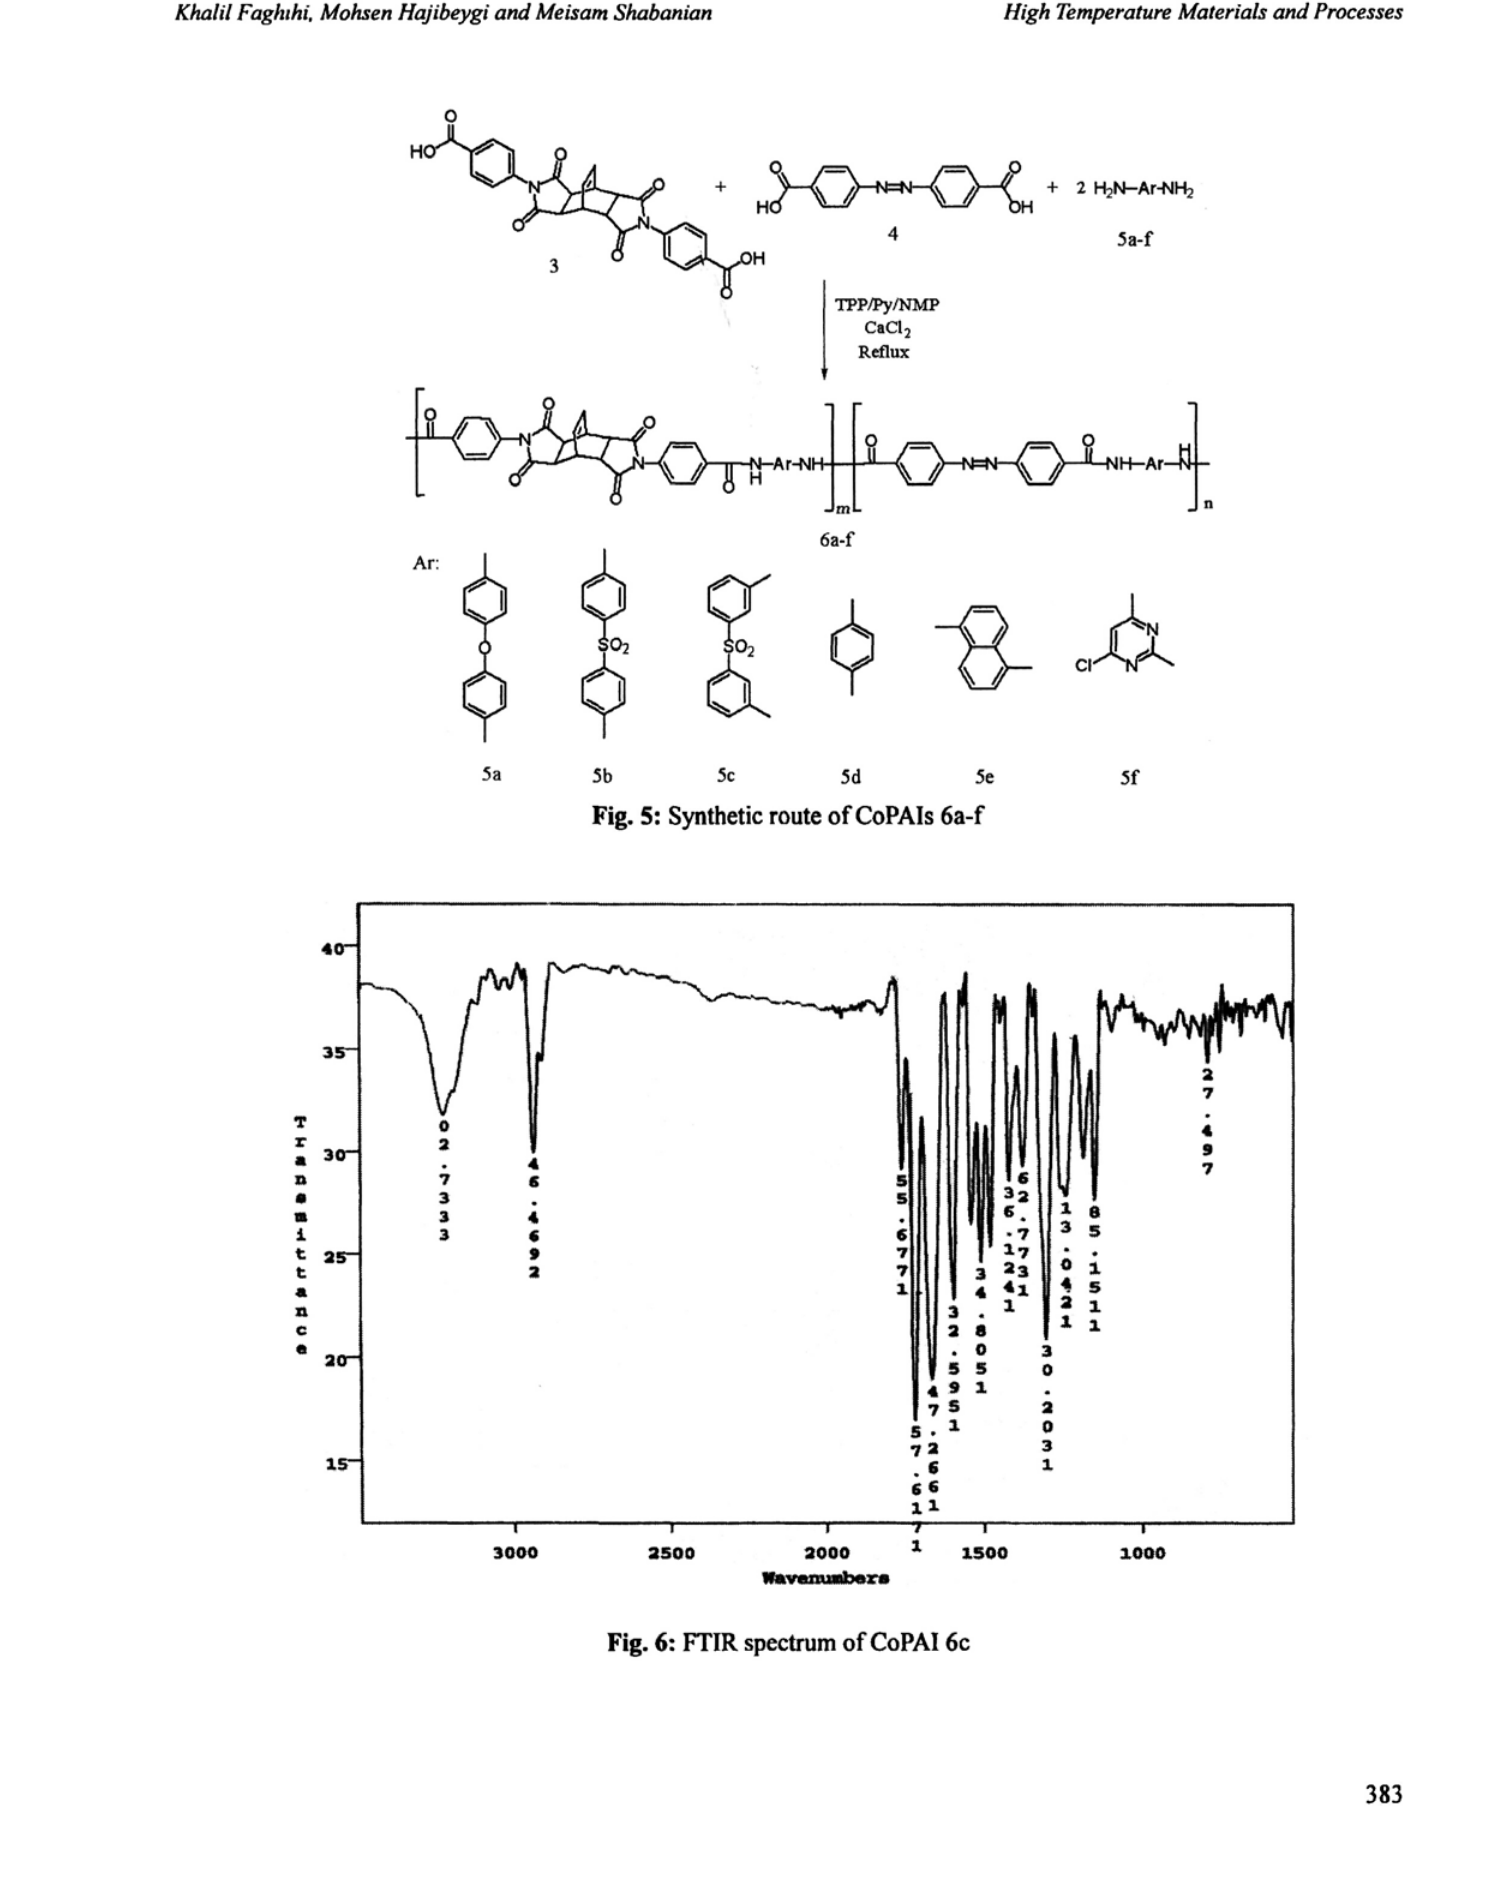
Fig. 6: FTIR spectrum of CoPAI